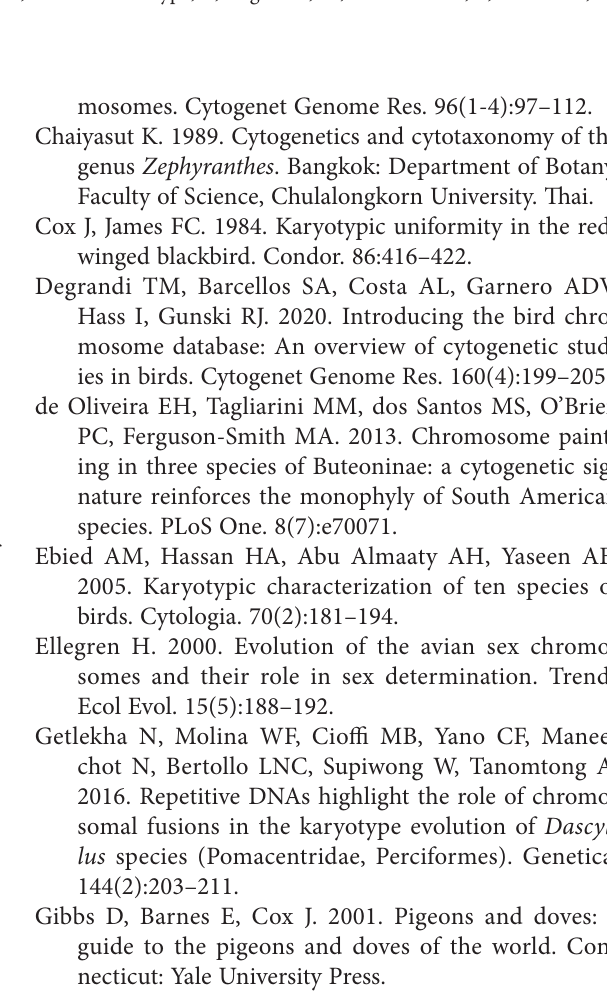
Abbreviations: Ch.p , chromosome pair; Ch.s , chromosome size; Ch.t , chromosome type; L , large size; M , medium size; S , small size; m , metacentric; sm , submetacentric; a ,